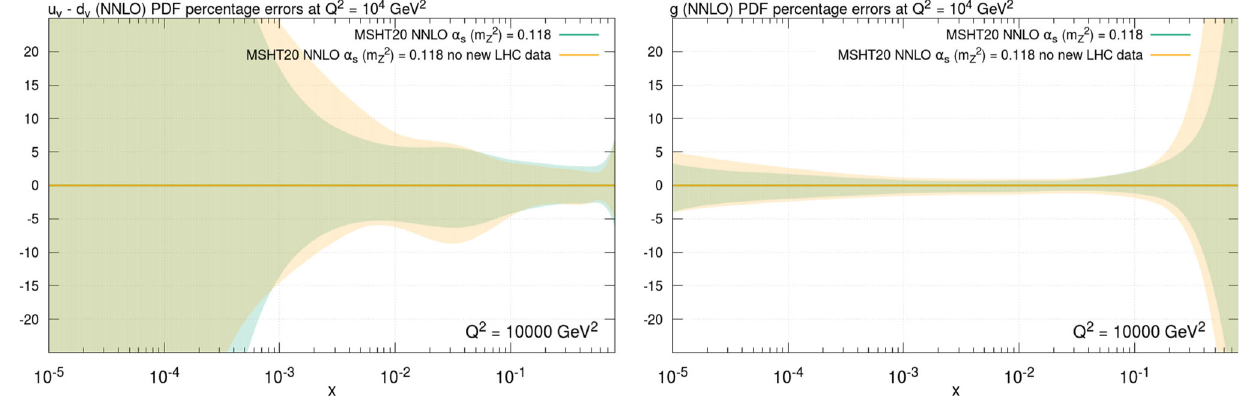
Fig. 54 (Left) u V − d V and (right) gluon PDF percentage errors upon removal of the new LHC data compared to MSHT20 at Q 2 = 10 4 GeV 2 at